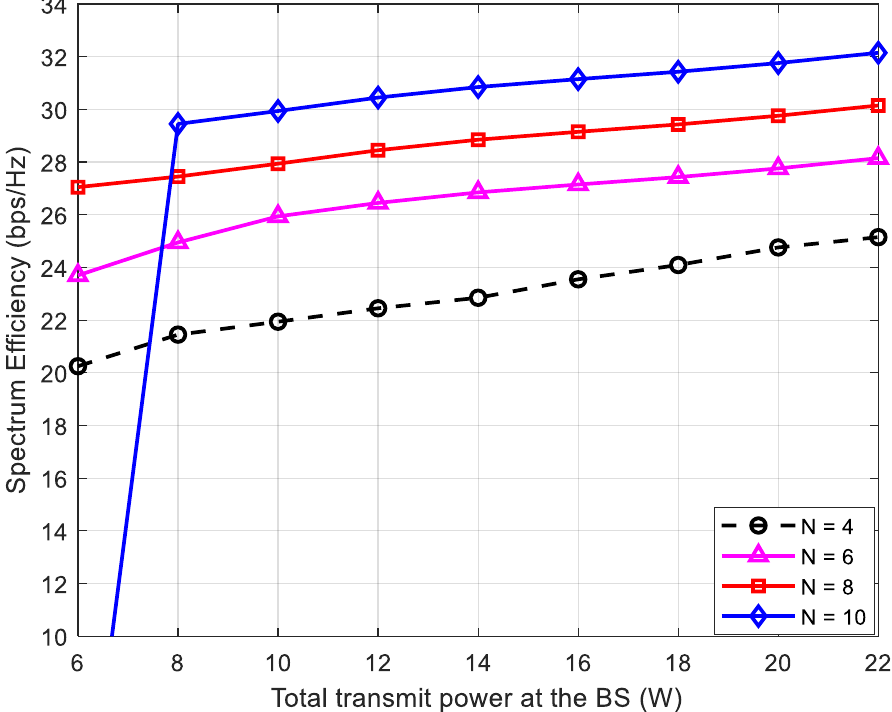
Figure 6. Spectrum efficiency versus total transmit power, at the BS, with different number of IIoT devices.